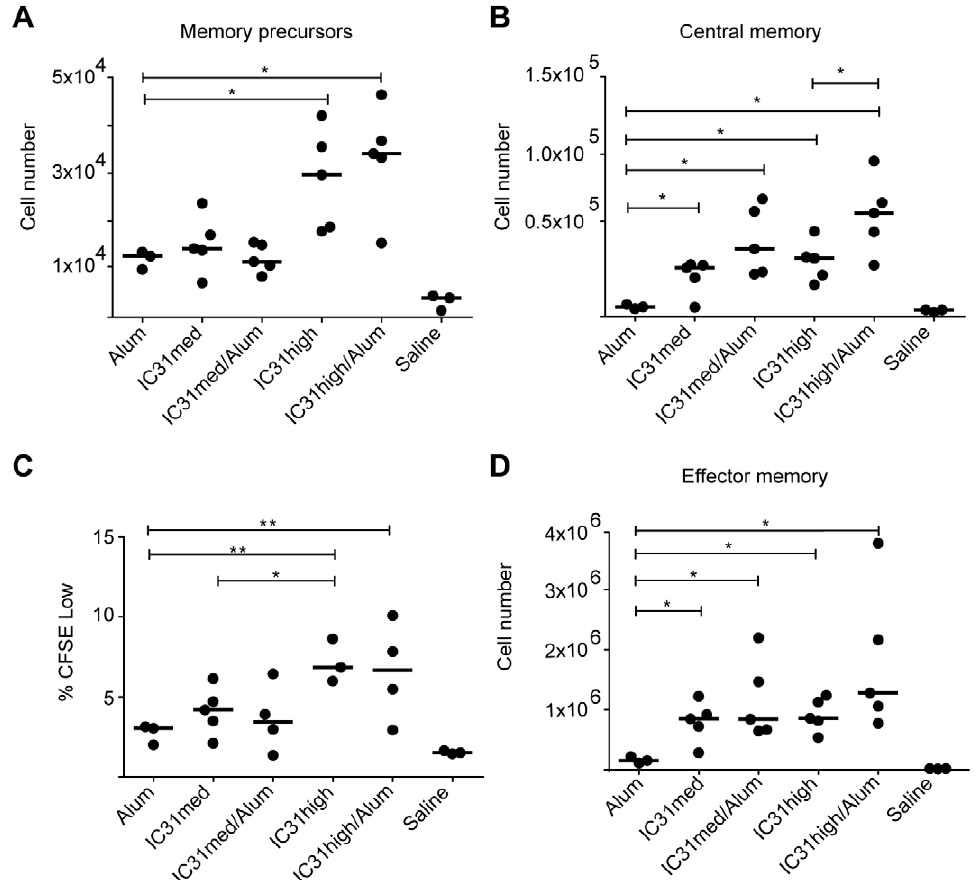
Figure 5. The memory T-cell pool is enhanced by Env/IC31 prime. A) At week 11, the numbers of CD8 + memory precursor cells (IFN- c + and/ or TNF- a + CD8 + KLRG1-low CD127 + ) in the spleen were determined for mice that were primed with Env-CN54 gp140 with various adjuvants as indicated and boosted with NYVAC-CN54. The graph shows the results obtained after in vitro stimulation with peptide pool 1. B) At week 15, memory T-cell numbers were assessed in the spleen. Central memory T cells were defined as CD8 + T cells secreting IFN- c and/or TNF- a with high expression of CD62L. The graph depicts central memory cell numbers induced by the various vaccination regimens following in vitro re-stimulation with peptide pool 1. C) Proliferation of spleen CD8 + T cells from week 15 was determined by CFSE dilution. The graph shows the frequency of proliferating CD8 + T cells following in vitro stimulation with peptide pool 1 for 3 days. D) Effector memory T cells from week 15 were defined as CD8 + T cells secreting IFN- c and/or TNF- a , expressing low levels of CD62L. The graph shows the values obtained after in vitro stimulation with peptide pool 1. Bars indicate the median value. *p , 0.05 and **p , 0.01. Each data point corresponds to a single mouse in the experimental group.